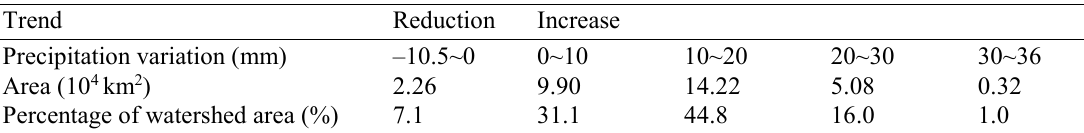
Table 2 Spatial variation of precipitation in